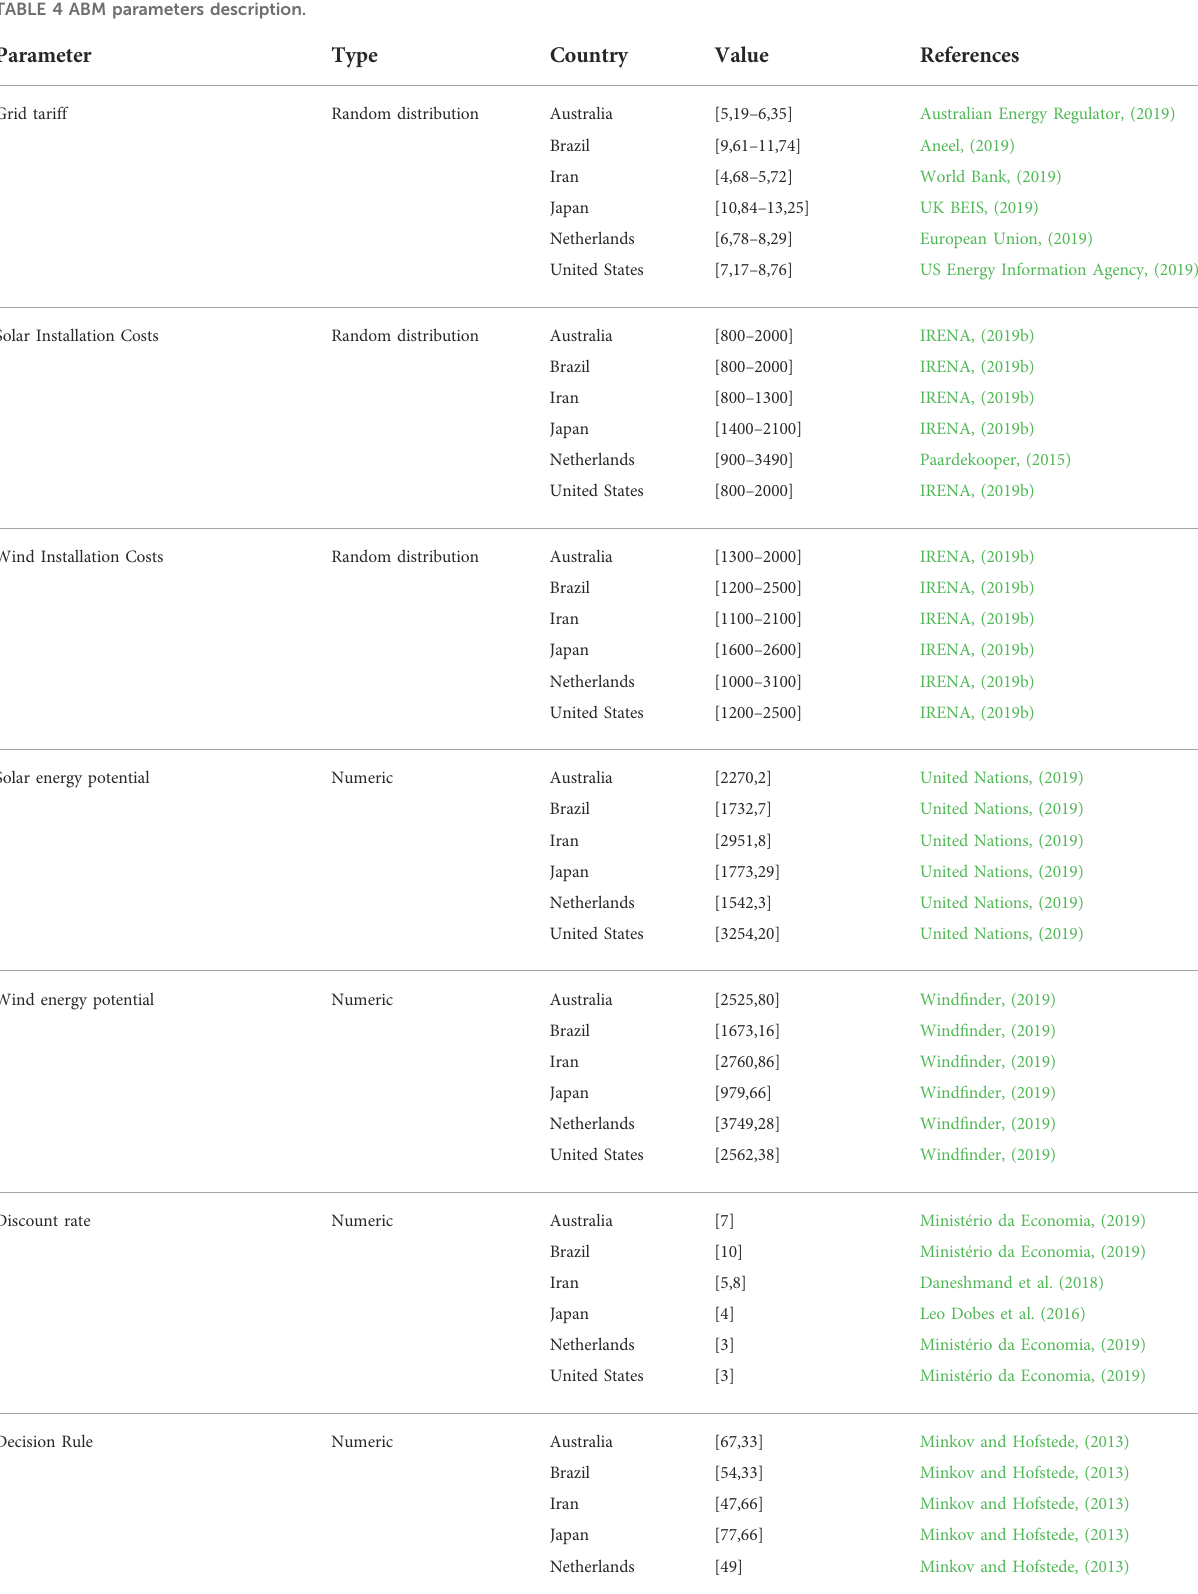
TABLE 4 ABM parameters